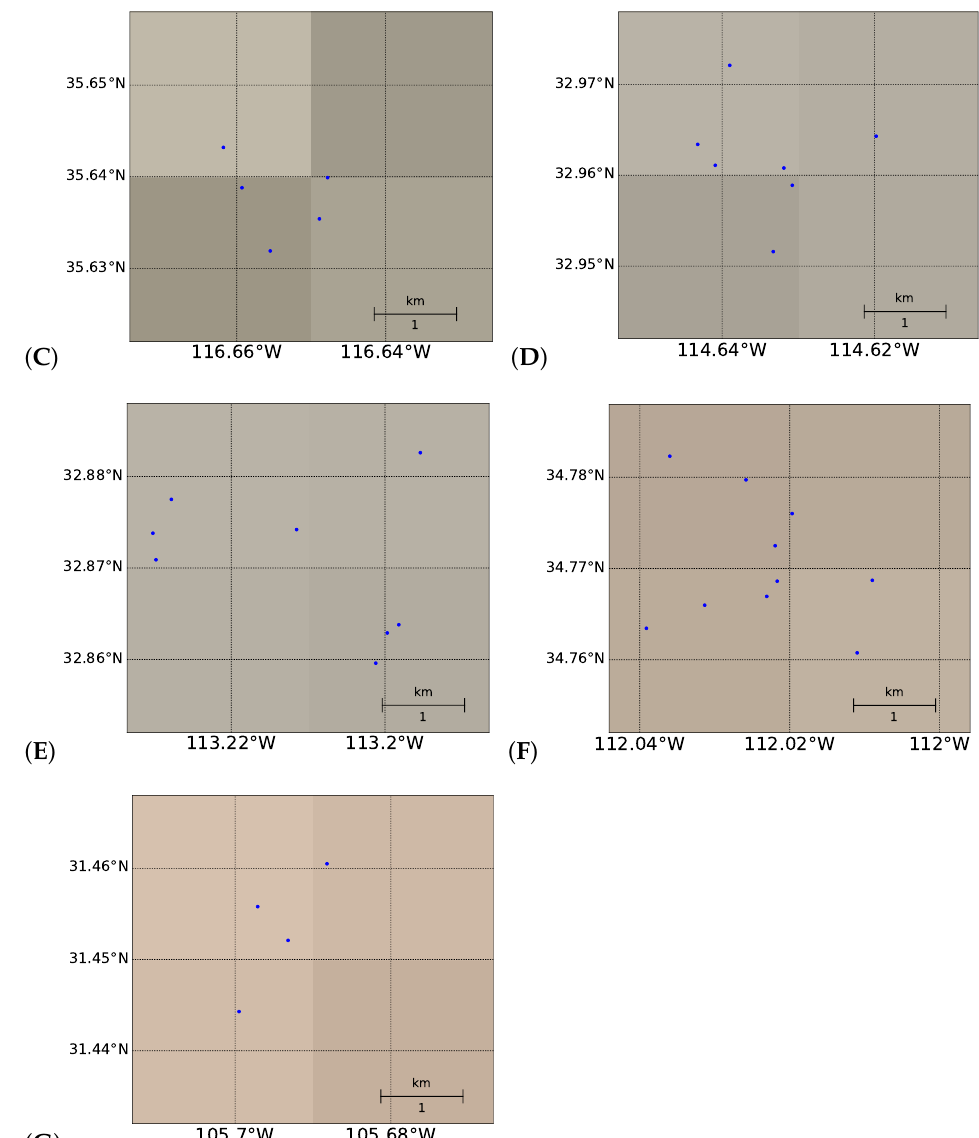
Figure 3. Data from USGS sites in sub-regions ( A – G ), with each specific location in each sub-region shown in subplots 2 ( A – G ), as labeled in Figure 2. Differences in background color are topographic variations (not easily visible due to the zoom-in on the relevant